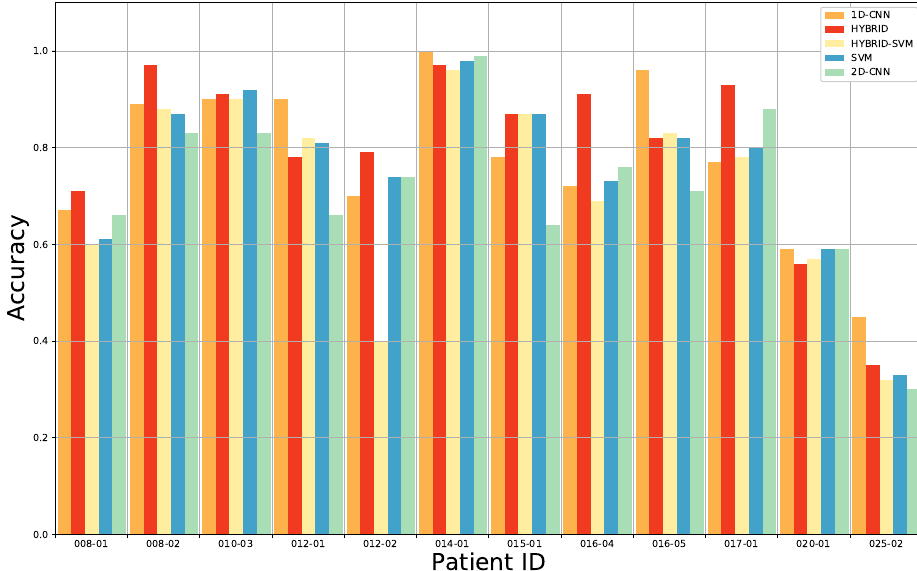
Figure 4. Average accuracy results of the leave-one-patient-out cross-validation of the four-class classification for each method: 1D CNN, 3D–2D hybrid CNN, 3D–2D hybrid CNN + SVM, only SVM and the 2D CNN.